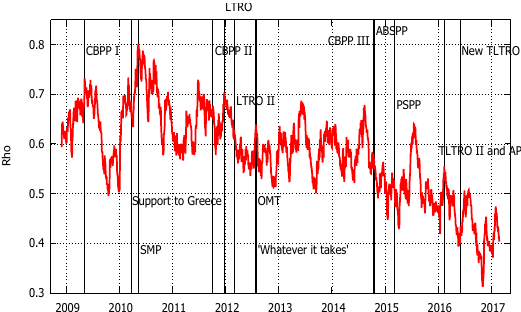
Figure A3. The ˆ ρ t together with key policy in Table A6.